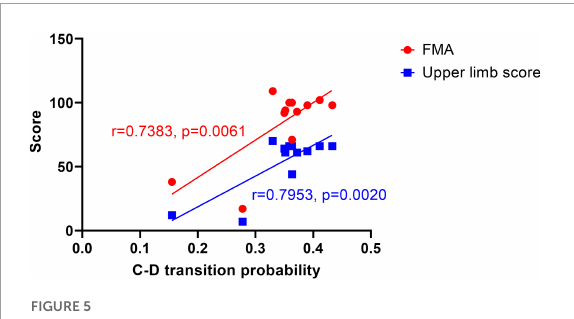
FIGURE5 Linear regression graph between C-D transition probability and scores. The dots represent the FMA score, and the squares represent the upper limb score.